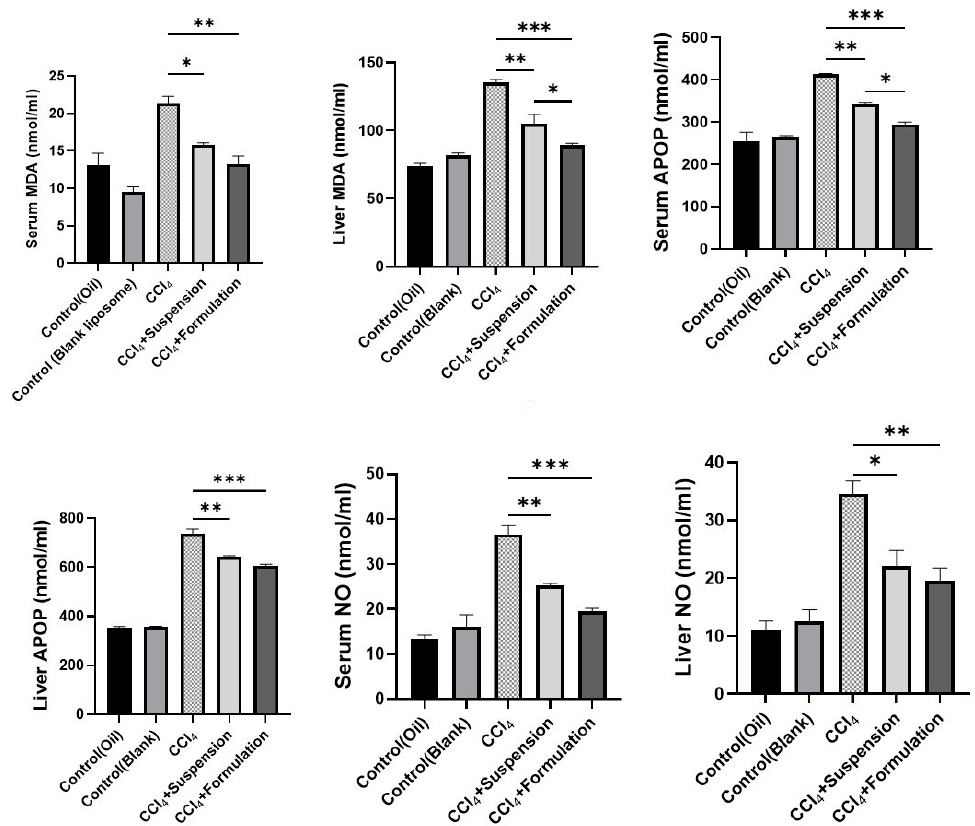
Figure 7. Effect of B. lacera leaf extract and its liposomal preparation on oxidative stress markers. Data are presented as mean ± SEM, n = 6. where * p ≤ 0.05, ** p ≤ 0.01, *** p ≤ 0.001, when compared between the CCl 4 , CCl 4 + suspension and CCl 4 + formulation (liposomal) groups. p ≤ 0.05 was considered statistical level of significance for all cases. MD: Malondialdehyde, APOP: Advanced protein oxidation products, NO: Nitric